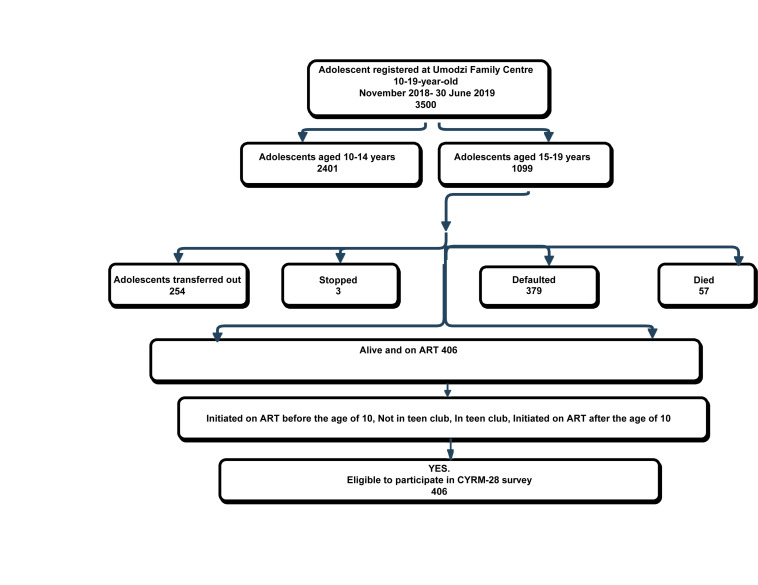
Summary of study sample.